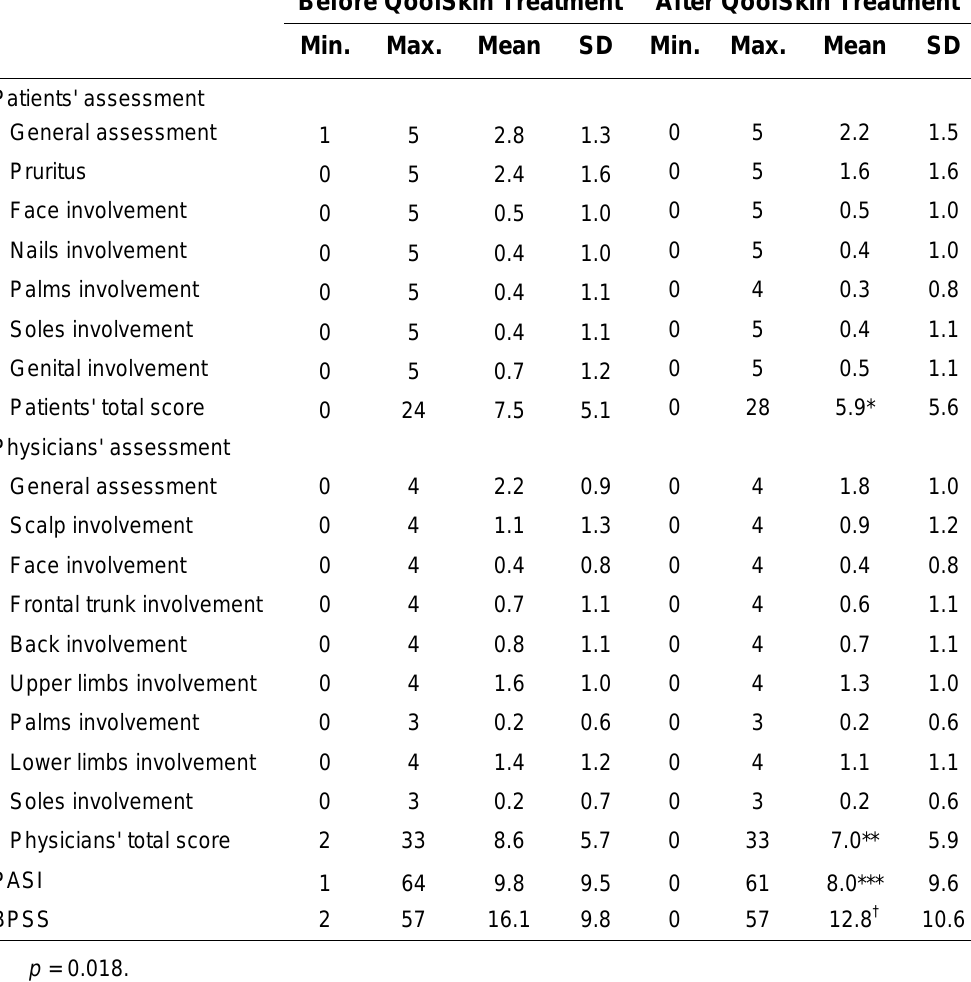
Assessment of Psoriasis Severity Before and After QoolSkin